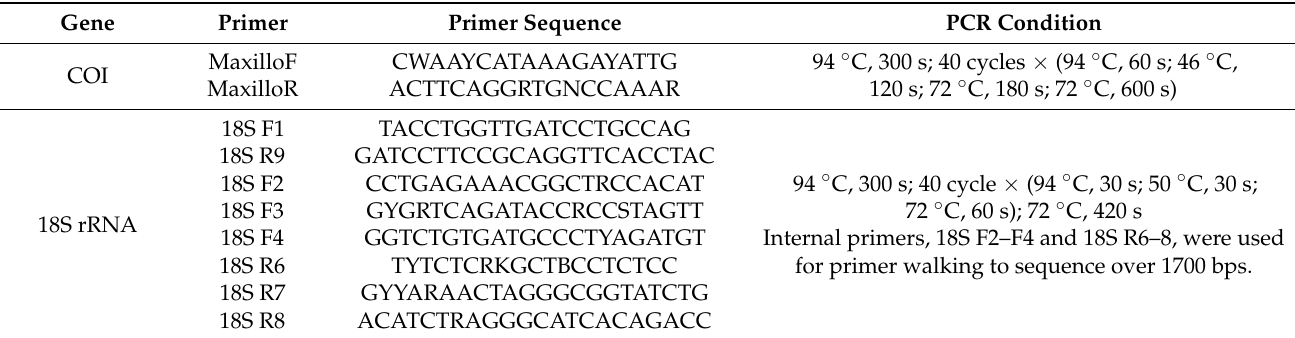
Table 2. Primer sequences and PCR conditions used in the present